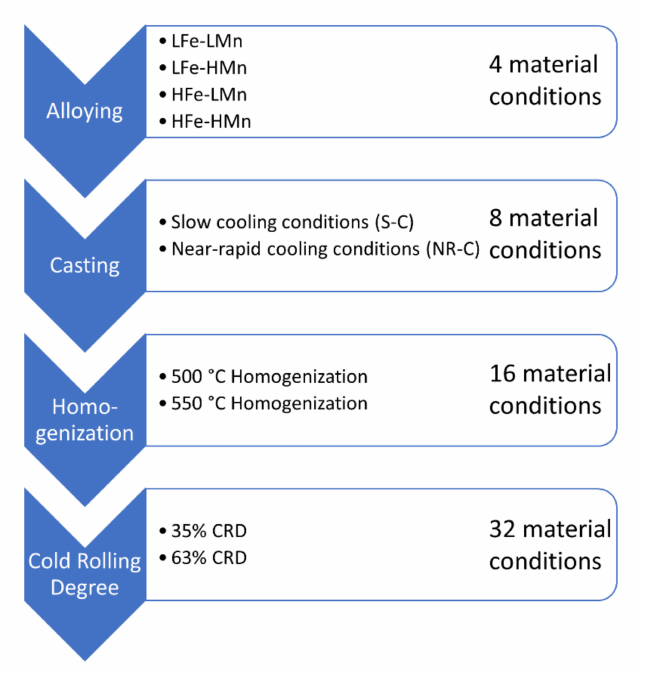
Figure 1. Sample processing scheme, including all variations of the individual process